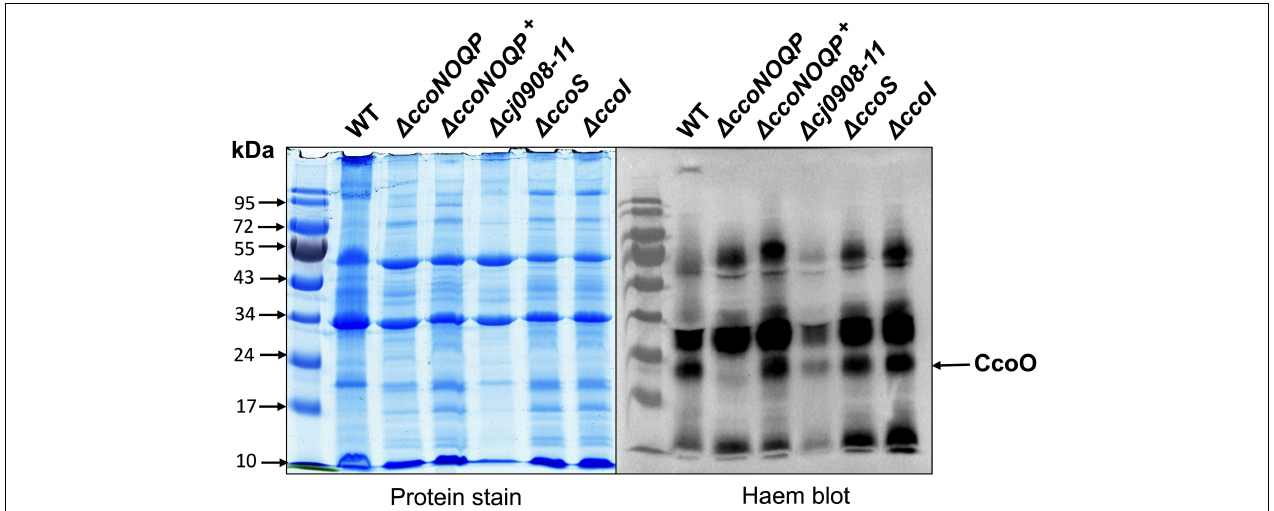
FIGURE 4 | Deletion of cj0908–911 , ccoS or ccoI does not affect insertion of the CcoO cytochrome c into the cytoplasmic membrane. Samples of total membrane proteins of wild-type, (cid:49) ccoNOQP , (cid:49) ccoNOQP + , (cid:49) cj0908-cj0911 , (cid:49) ccoS , and (cid:49) ccoI , were mildly denatured in the absence of mercaptoethanol to preserve attachment of C-haems to Cys residues and 20 µ g protein in each lane was loaded on 10% SDS-PAGE gels. Gels were either stained with Coommassie brilliant blue ( left panel ) or for haem-associated peroxidase activity ( right panel ) using a standard enhanced chemiluminescence kit (See section “Materials and Methods”). The CcoO band (arrowed) is missing in (cid:49) ccoNOQP only. CcoP is not visible because of intense c-type cytochrome bands of a similar